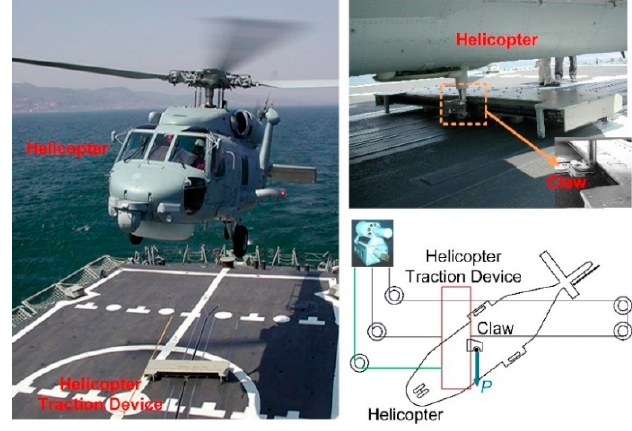
Figure 1. The working environment of helicopter traction device.